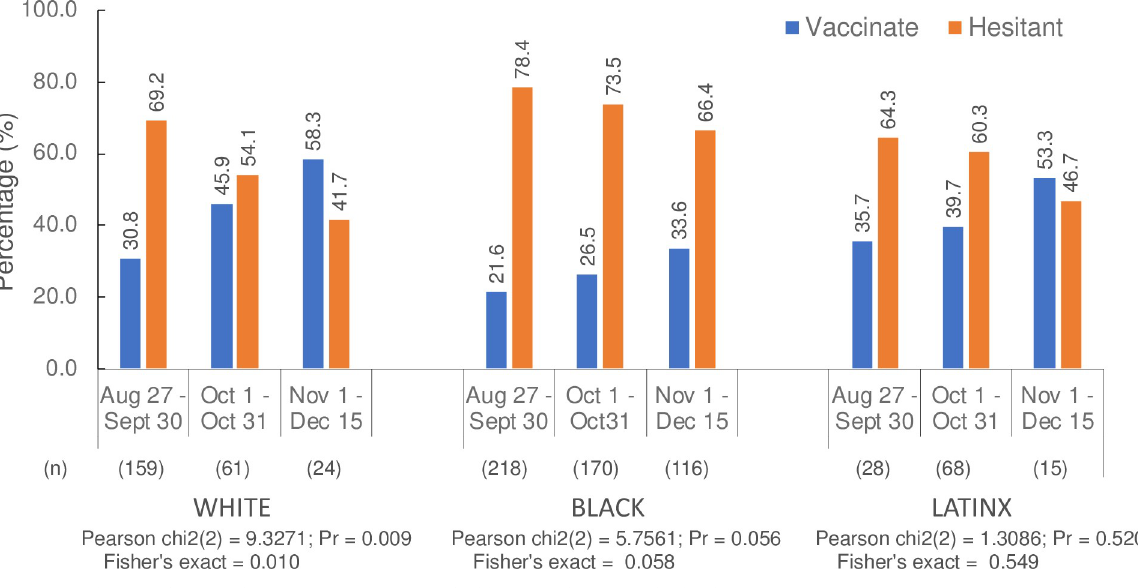
Fig 2. Distribution of vaccine hesitancy over time stratified by race/ethnicity and calendar